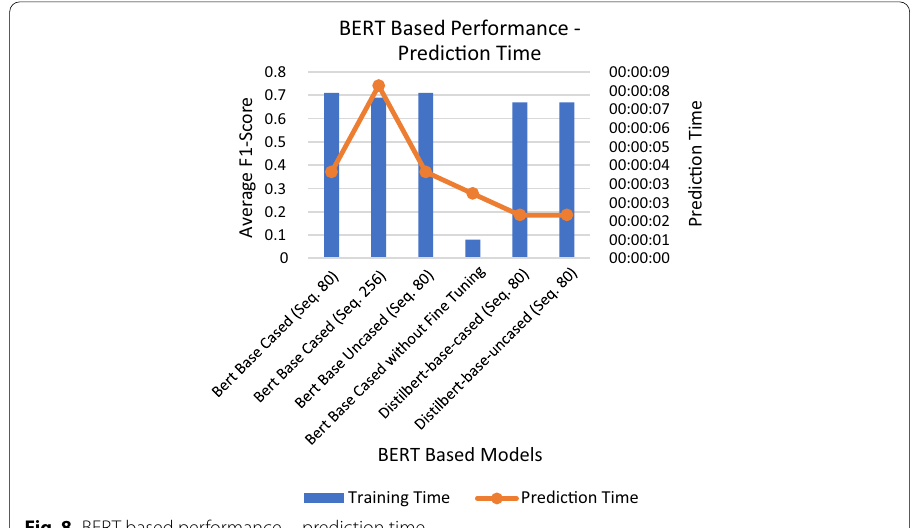
Fig. 8 BERT based performance—prediction